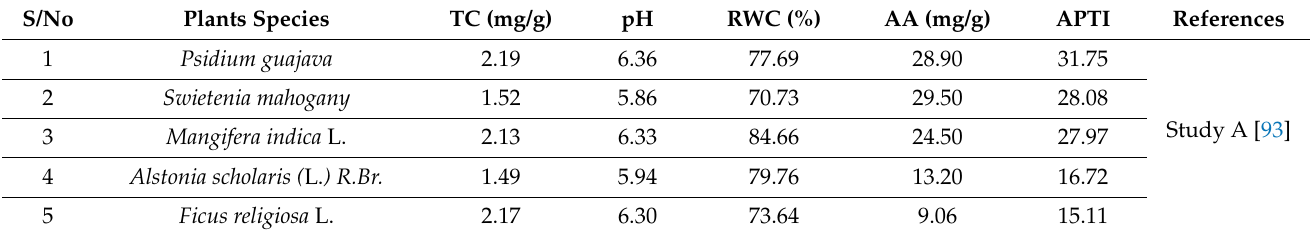
Table 4. Biochemical parameters along with APTI values of the plants from the